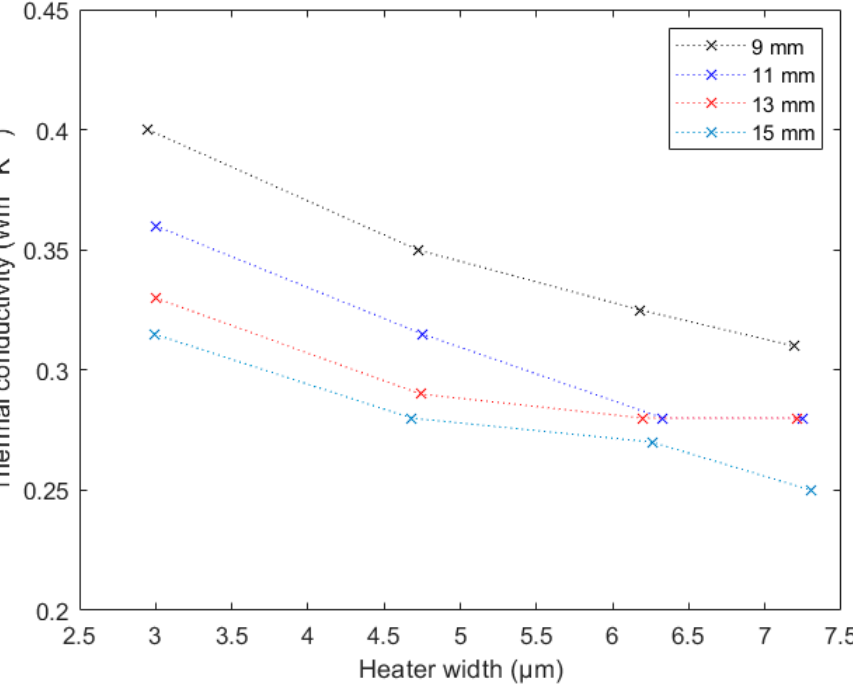
Figure 9. Measured thermal conductivity of 100 nm thin SiO 2 film. The different colors correspond to different heater lengths as indicated in the inset.